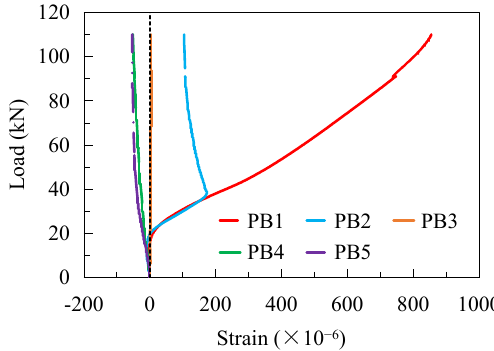
Figure 9. Strains on the PBL connectors.